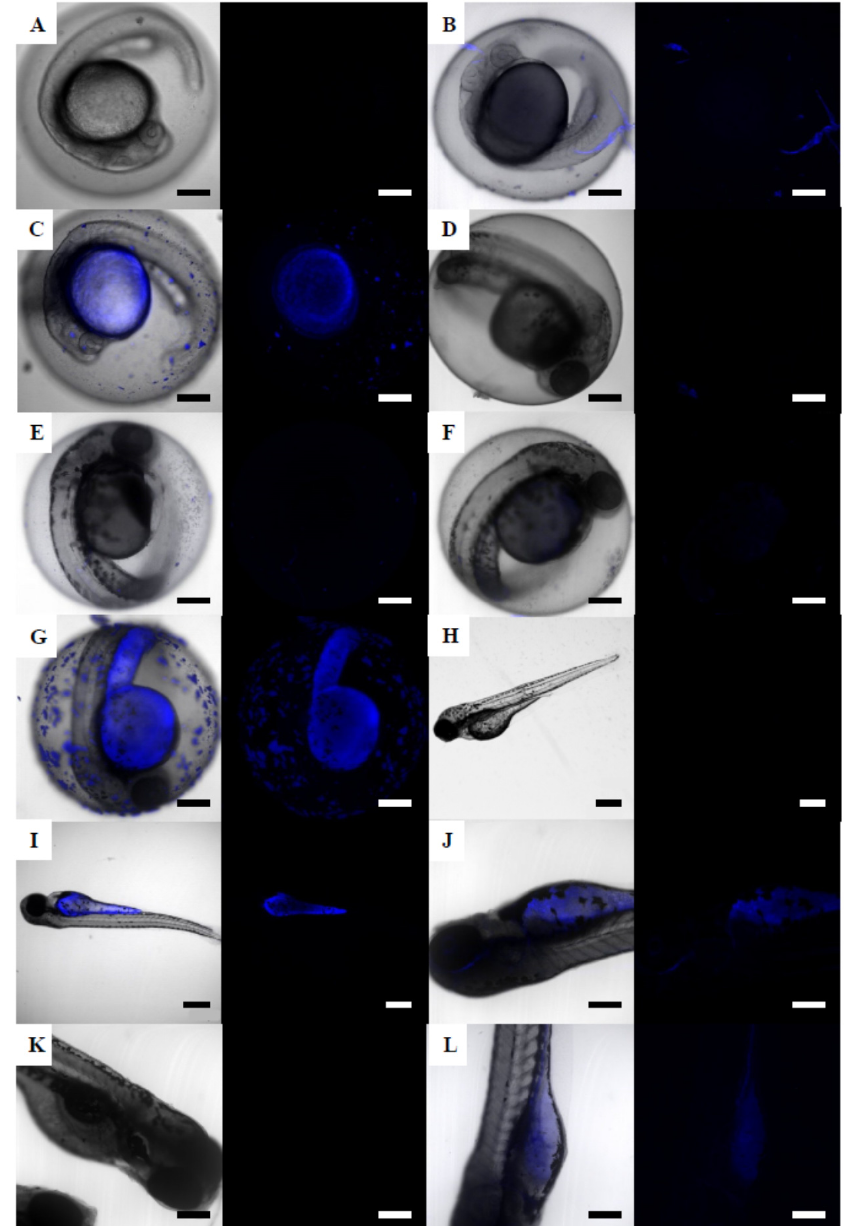
Figure 5. Confocal micrograph stacks of zebrafish embryos at different stages of development exposed to 500 nm NPs-B(a)P. ( A ) 24 hpf unexposed control embryo; ( B ) 24 hpf embryo exposed to 0.687 mg/L; ( C ) 24 hpf embryo exposed to 6.87 mg/L; ( D ) 48 hpf unexposed control embryo; ( E ) 48 hpf embryo exposed to 0.687 mg/L; ( F ) 48 hpf embryo exposed to 0.687 mg/L; ( G ) 48 hpf embryo exposed to 6.87 mg/L; ( H ) 72 hpf unexposed control embryo; ( I ) 72 hpf embryo exposed to 6.87 mg/L; ( J ) 96 hpf embryo exposed to 0.687 mg/L; ( K ) 120 hpf unexposed control embryo; ( L ) 120 hpf embryo exposed to 0.069 mg/L. Scale bars: 200 µm ( A – G , J – L ) and 300 µm ( H , I ). Fluorescence due to the exposure to 4.5 µm MPs-B(a)P (Figure 6) was first detected in 24 hpf embryos exposed at concentrations higher than 5.01 mg/L (Figure 6A,B). At 5.01 mg/L, fluorescence was only detected over the embryo chorion (Figure 6A), and, at the